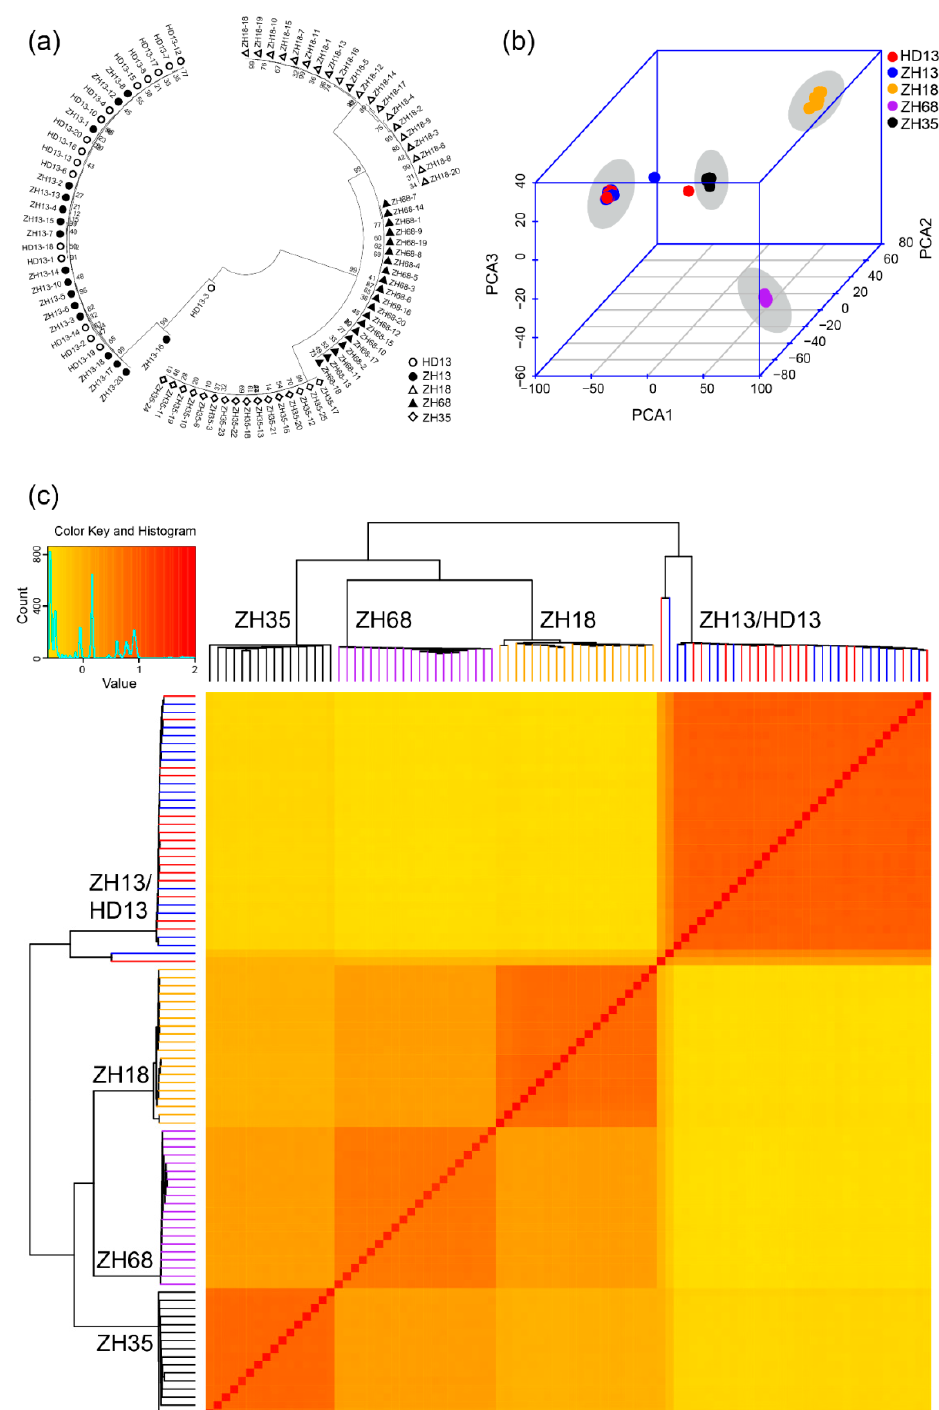
Figure 2. Identification of cultivar distinctness of five soybean cultivars based on the SNPs discovered by SLAF-seq. ( a ) The phylogenetic analysis. White circles represent cv. Hedou 13 (HD13), black dots represent cv. Zhonghuang 13 (ZH13), white triangles represent cv. Zhonghuang 18 (ZH18), black triangles represent cv. Zhonghuang 68 (ZH68), white diamonds represent cv. Zhonghuang 35 (ZH35); ( b ) The principal component analysis. Red: HD13, blue: ZH13, orange: ZH18, purple: ZH68, black: ZH35. The grey shadow indicates the cluster of the cultivar; ( c ) Heatmap and dendrogram of a stepwise kinship matrix. Colors indicate the cultivars: Red: HD13, blue: ZH13, orange: ZH18, purple: ZH68, black: ZH35.